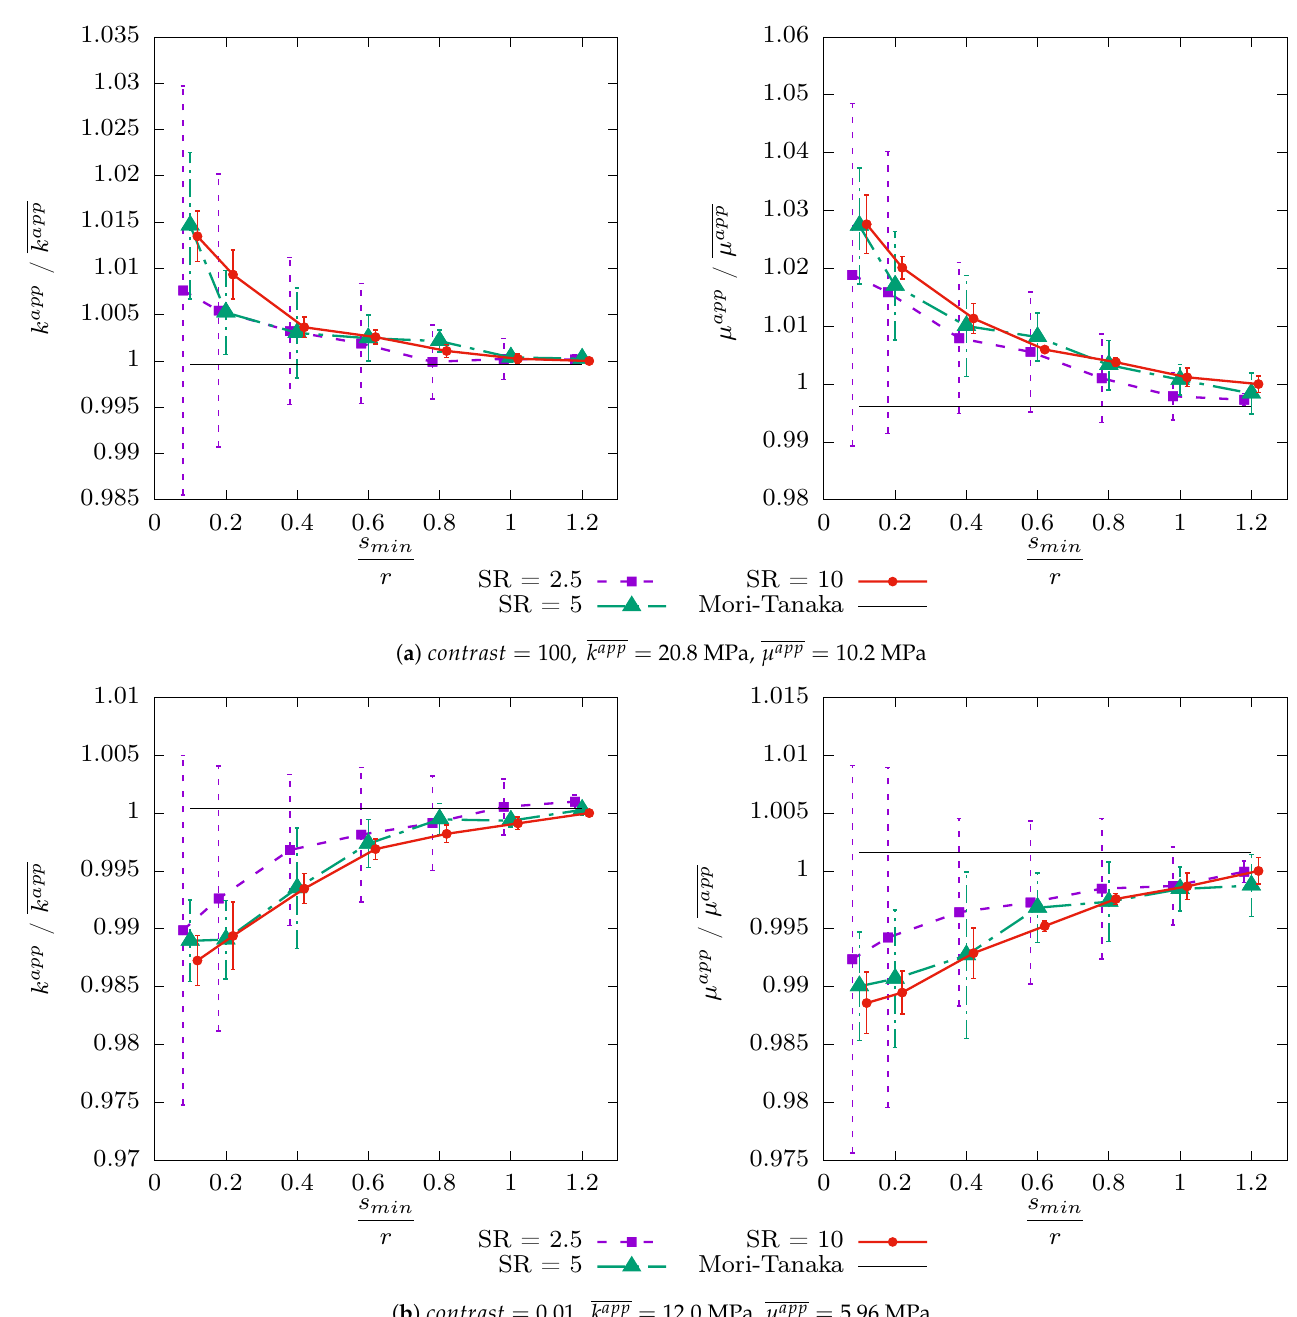
Figure 2. Mean values and standard deviations on the mean value for the apparent moduli as a function of the packing parameter s min / r ( r = 10 µ m) for a volume fraction of inclusions f v = 13.4 %. For clarity, the error bars and dots are slightly shifted around for each studied minimum